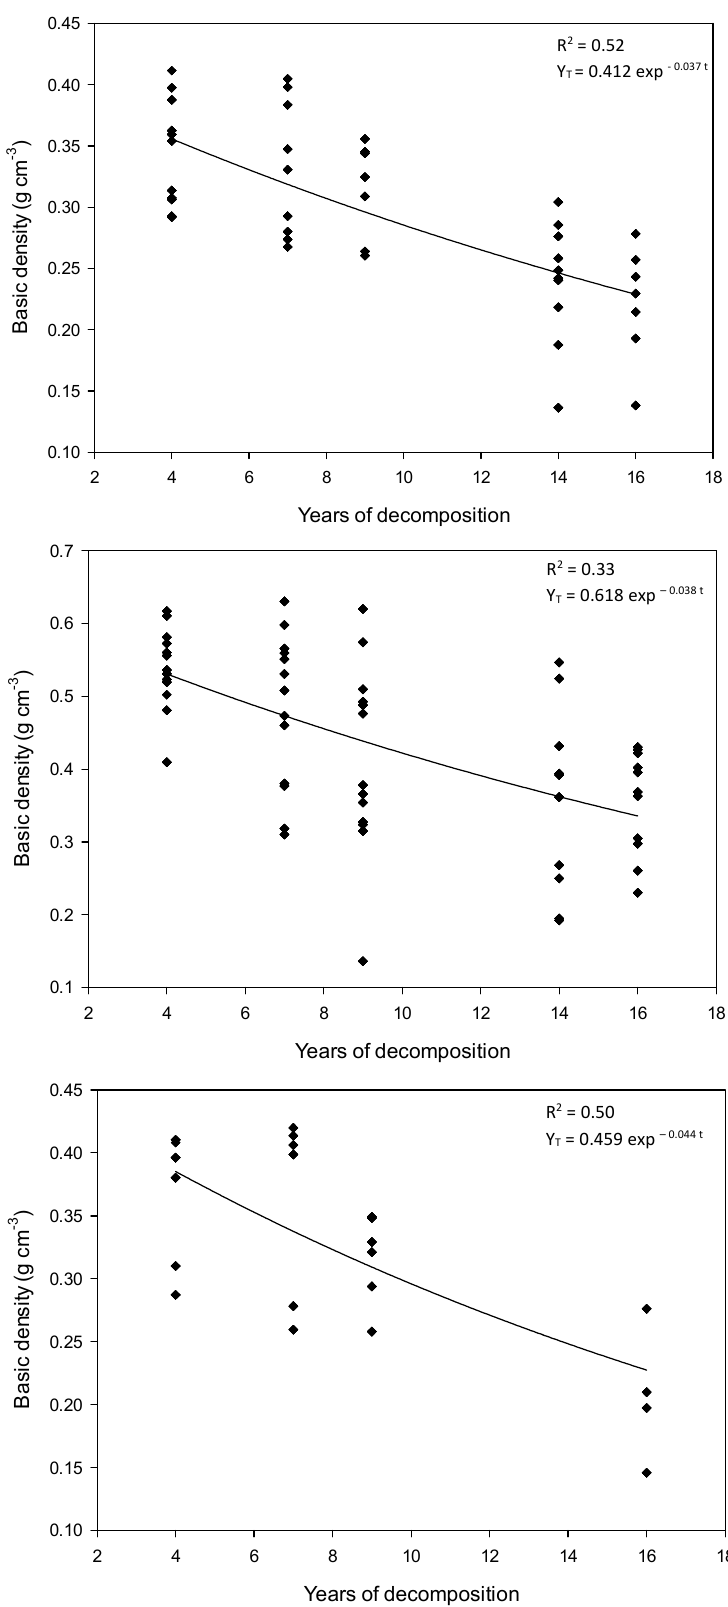
Figure 3. Exponential decay curves describing the decomposition rate of Sitka spruce logs (top), branches (middle), and stumps (bottom) from the relationship between density and time of decay (all equations are significant at p < 0.05, parameters are described in Table 4).